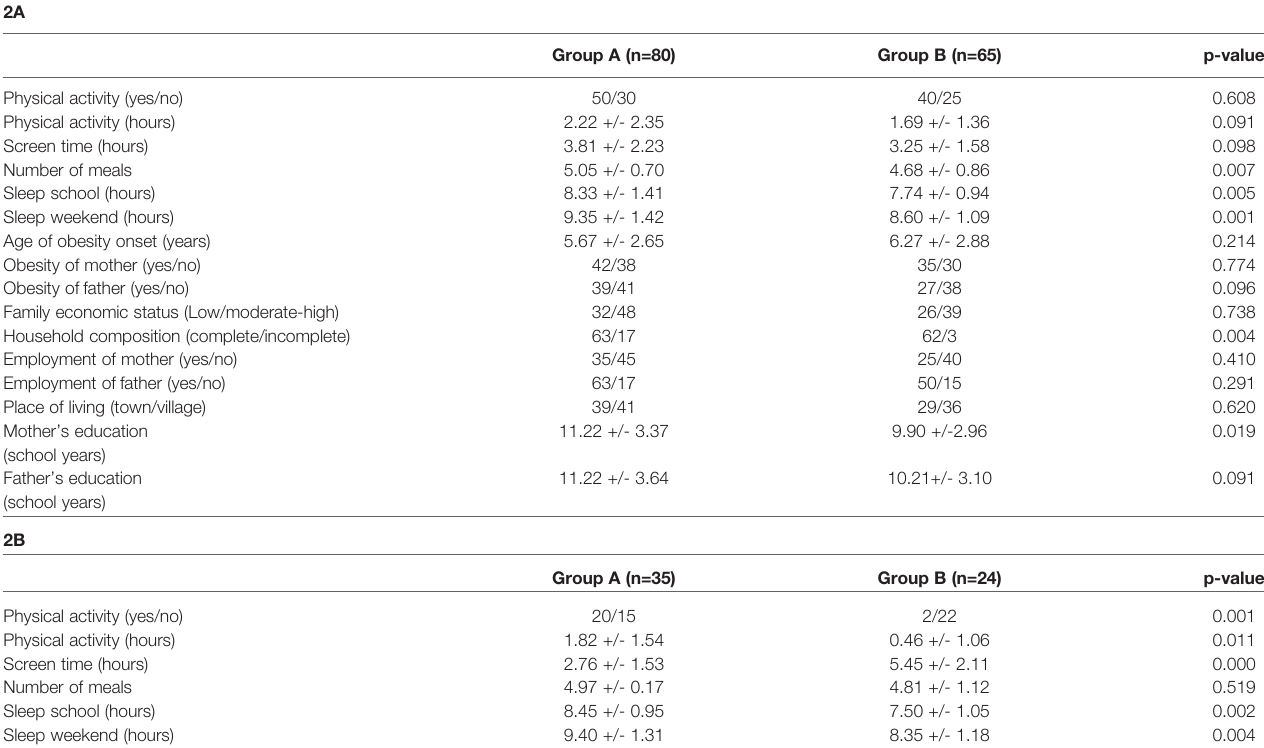
TABLE 2 | Comparison analysis between groups on baseline (2A) and 12-month (2B) anamnestic assessment.